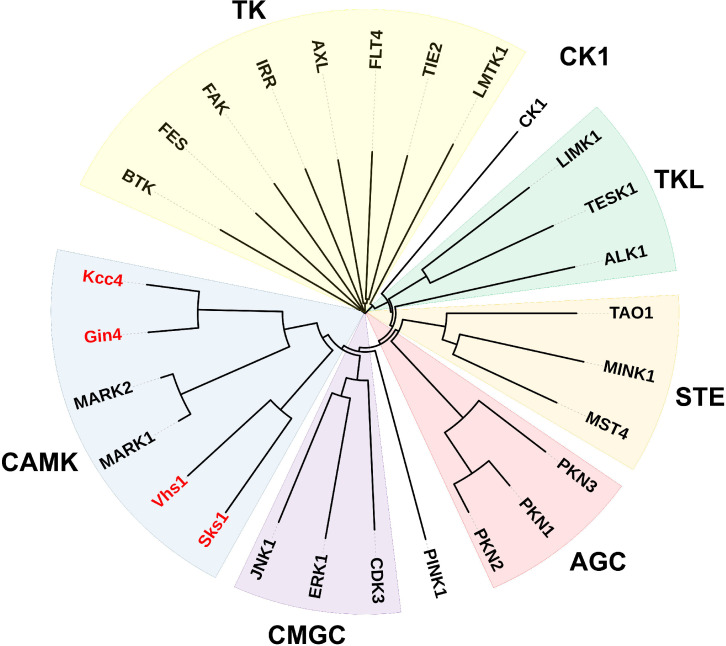
Yeast ubiquitin kinases Sks1, Vhs1, Gin4, and Kcc4 cluster with human MARKs of the CAMK superfamily of kinases.Sequence alignment and phylogenetic neighboring of kinase domains were analyzed by Clustal Omega (EMBL-EBI) and the circular rooted phylogram was constructed using iTOL. Yeast Ub kinases (Sks1, Vhs1, Gin4, and Kcc4) are shown in red.